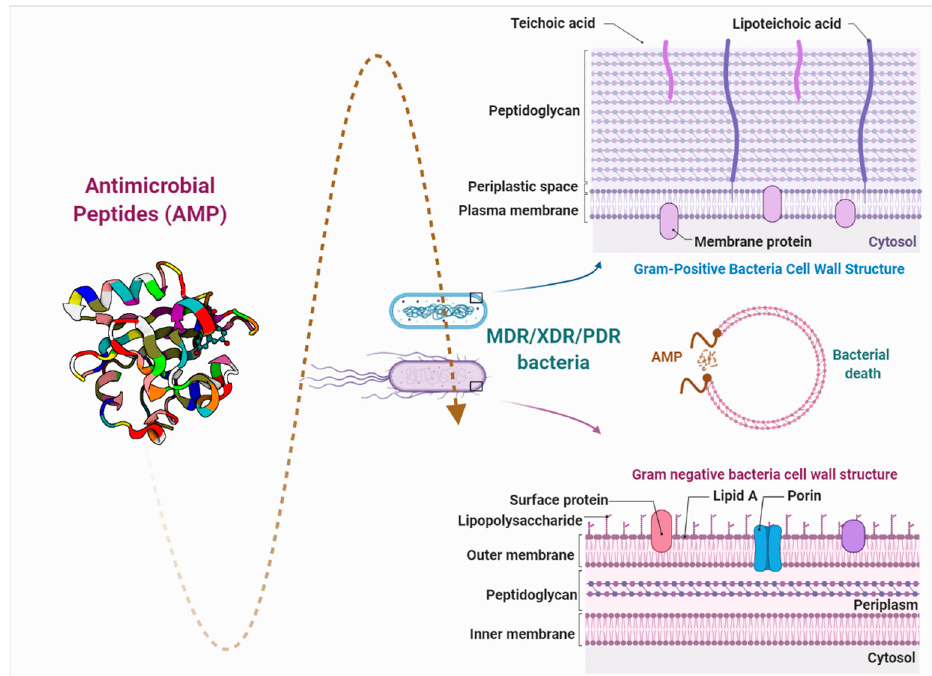
Figure 1. Brief description of the interaction between antimicrobial peptides and the bacterial cell wall. PDR : pandrug resistance, XDR: extensive drug resistance, and MDR : multidrug resistance.